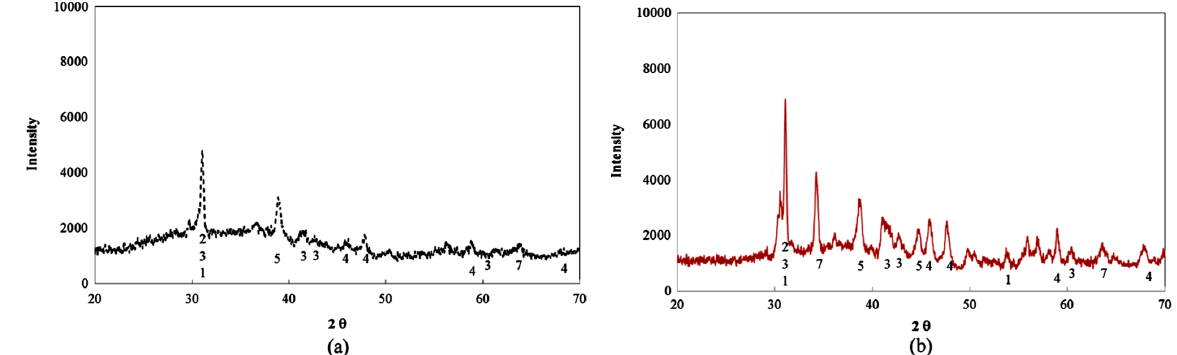
Figure 25. XRD spectrum ( a ) before and ( b ) after the dissolution of FA. Adapted from [108].